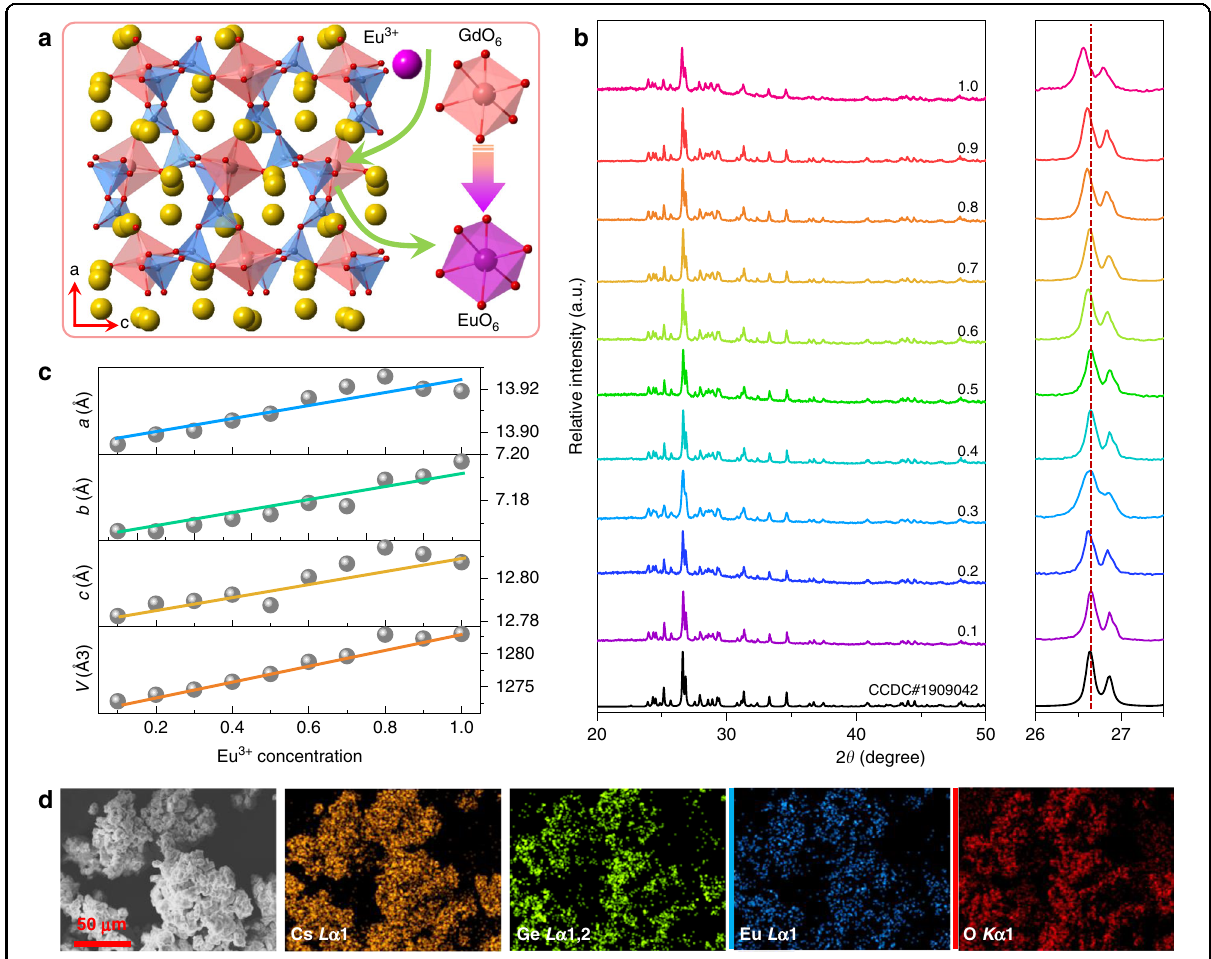
Fig. 1 Crystal structure and micromorphology. a Crystal structure of the Cs 3 GdGe 3 O 9 host compound (colour balls: Cs yellow, Gd light red, Ge light blue, O red). b XRD patterns (2 θ = 20 – 60°) and enlarged XRD patterns at 2 θ = 26 – 27.5° of CGGO: x Eu 3 + ( x = 0.1 – 1.0) samples. c The variation in cell parameters ( a , b , c , V) for CGGO: x Eu 3 + ( x = 0.1 – 1.0) samples. d Elemental mapping images of the CEGO